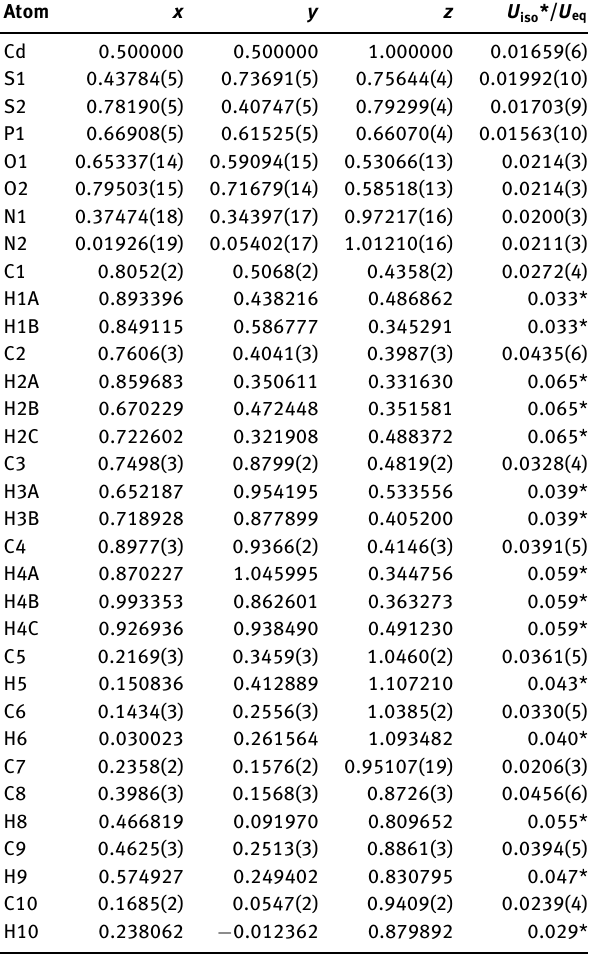
Table 2: Fractional atomic coordinates and isotropic or equivalent isotropic displacement parameters (Å 2